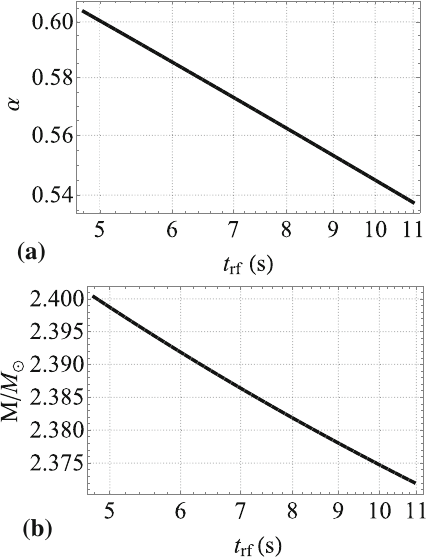
Fig. 8 The evolution of the mass and spin of BH, as a function of rest- frame time (t rf ) for GRB 180720B during the UPE phase ( t rf = 4 . 84– 10 . 89 s). The MeV energetic is paid by the exctractable energy of the Kerr BH (Eq. 15), leading to the reduction of the mass and spin during the UPE